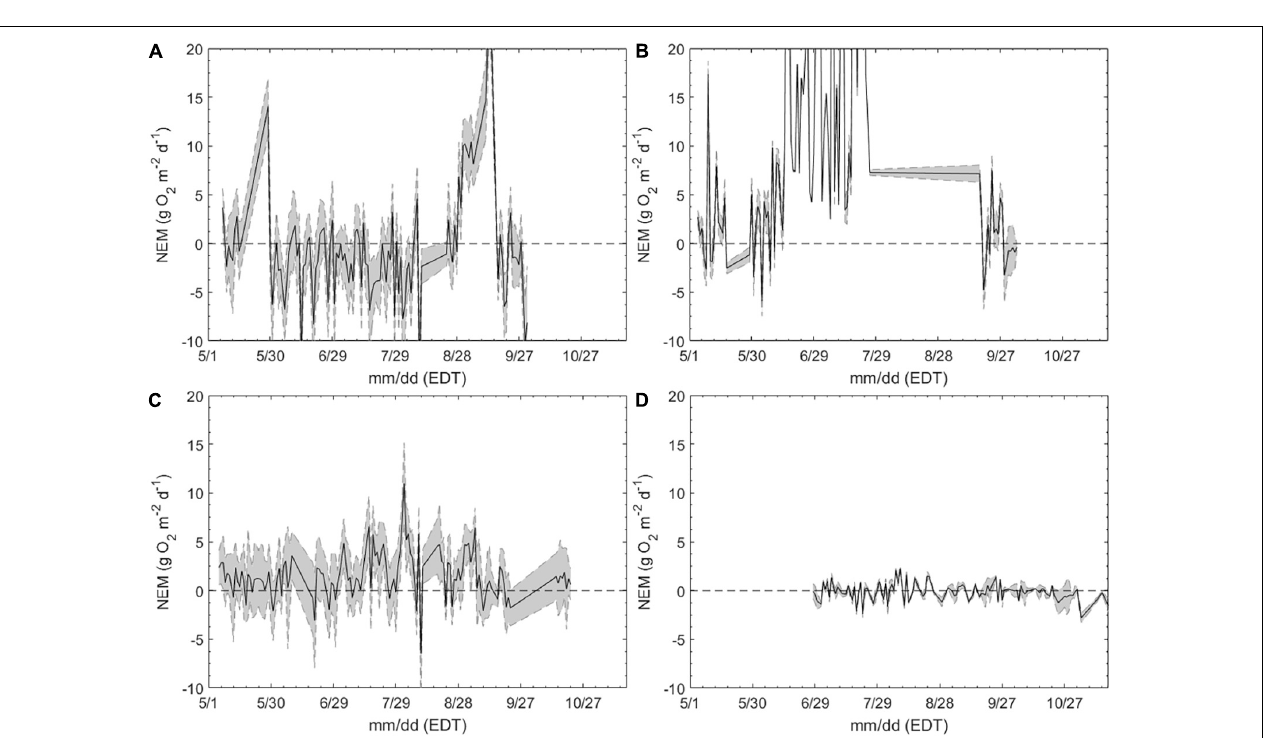
FIGURE 5 | Daily net ecosystem metabolism (NEM; g O 2 m − 2 d − 1 ) in a (A) salt marsh (SM-3), (B) a macroalgae bed (MA-1), (C) a seagrass bed (SG-1), and (D) an open water estuary (OW-1), May – October, 2015. Sites identical to Figures 3 , 4 . Shaded region bound by dashed lines indicates the calculated uncertainty due to the combined effects of lateral mixing and variability in gas transfer velocity.